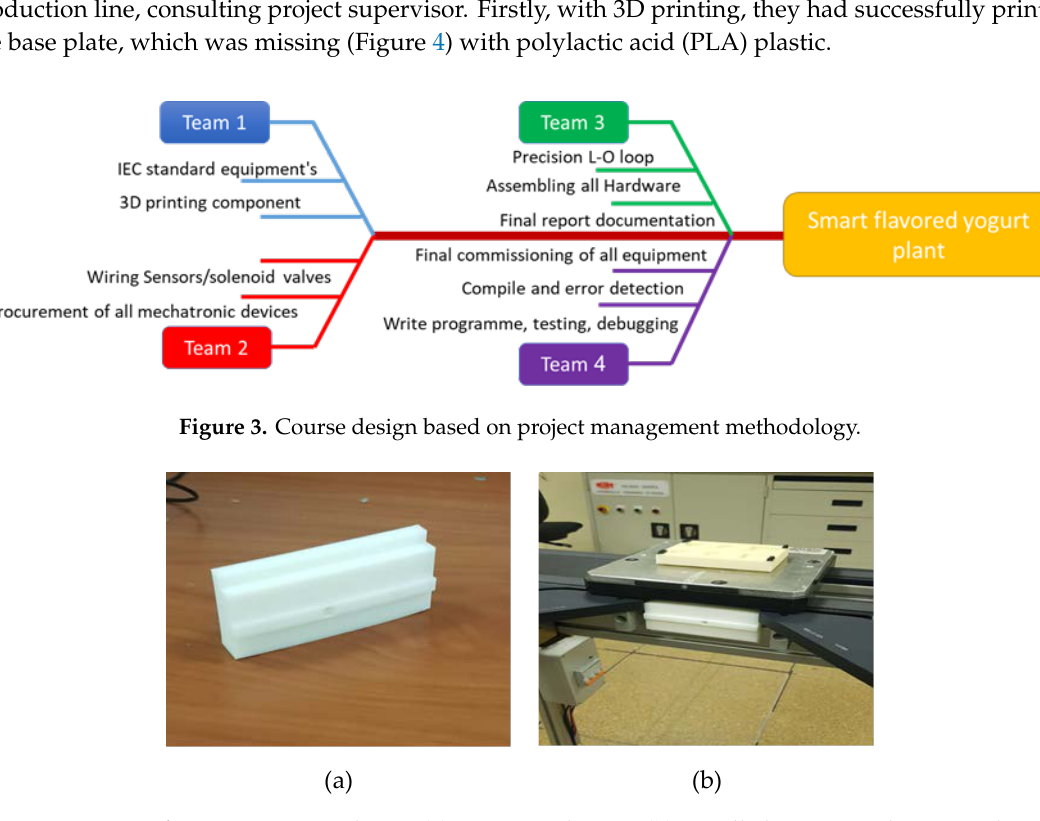
Figure 5. Defective conveyor object: ( a ) 3D printed item; ( b ) installed 3D Printed item in the conveyor system.